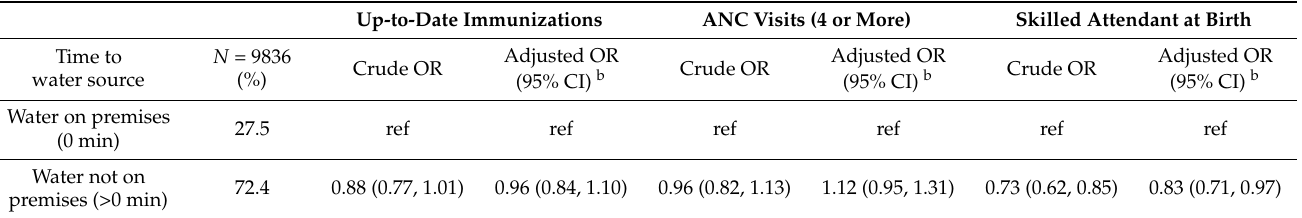
Table 6. Associations between walking time (in minutes) to water source and indicators of maternal and child health care services utilization among vulnerable women a